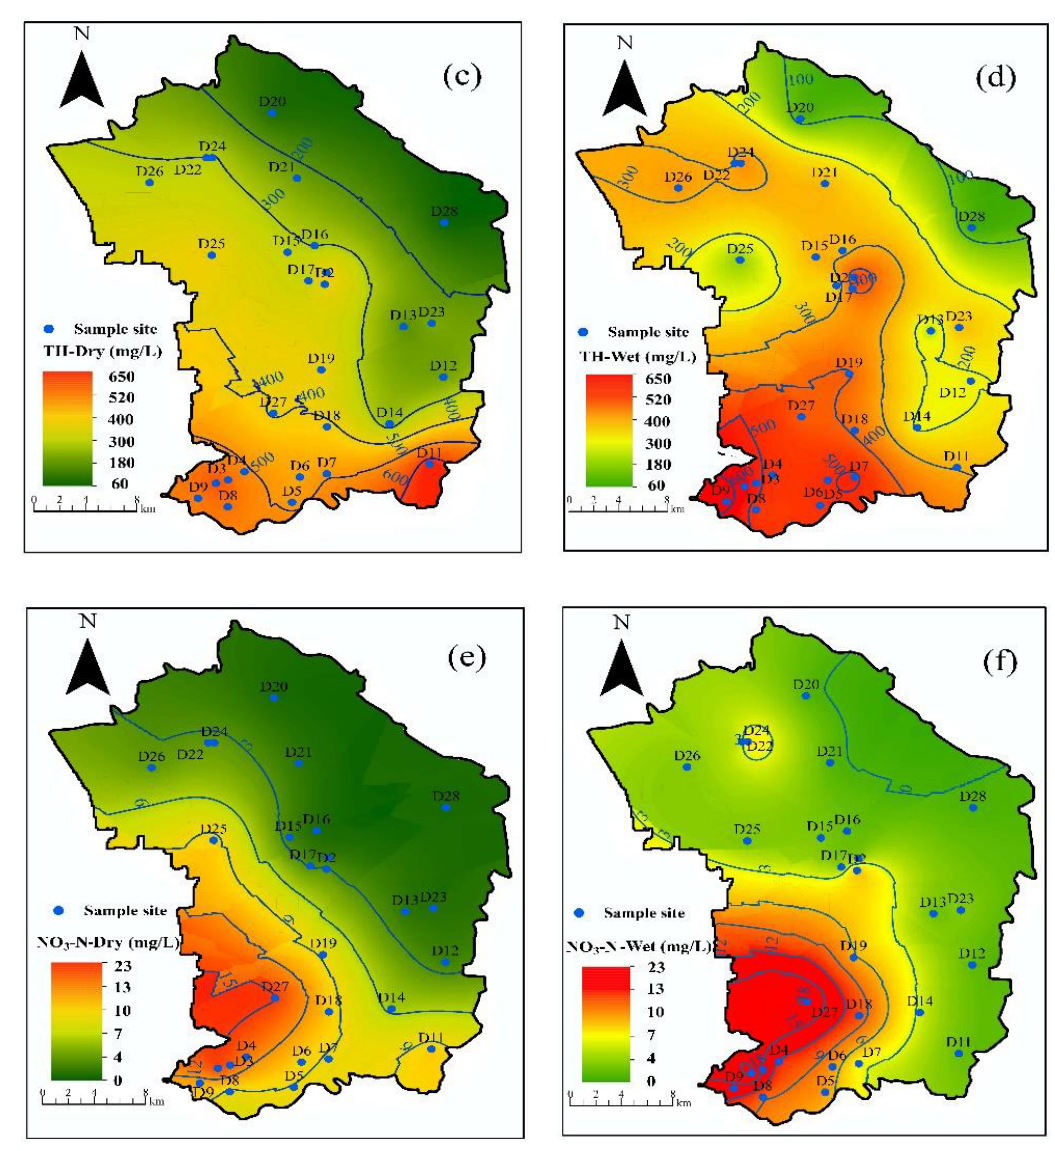
Figure 2. Spatial distribution of groundwater quality in the study area. ( a ) TDS in dry season. ( b ) TDS in wet season. ( c ) TH in dry season. ( d ) TH in dry season. ( e ) NO 3 -N in dry season. ( f ) NO 3 -N in wet season.